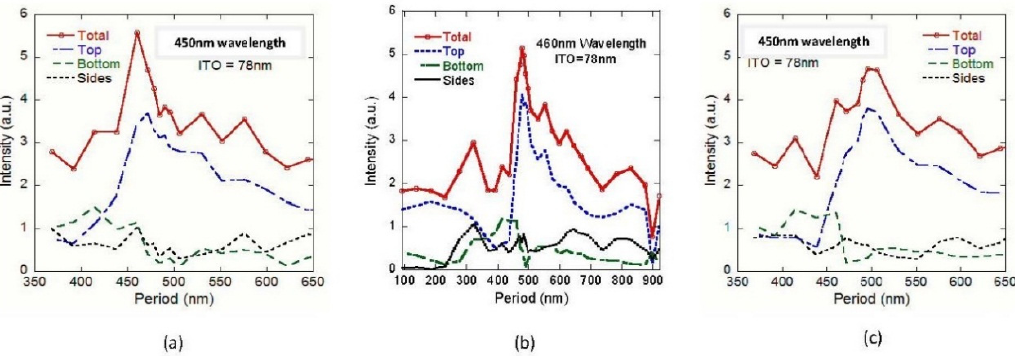
Figure 9. Total light output for ITO nano-top grating when the free space wavelength is at ( a ) 450 nm, ( b ) 460 nm, and ( c ) 470 nm.